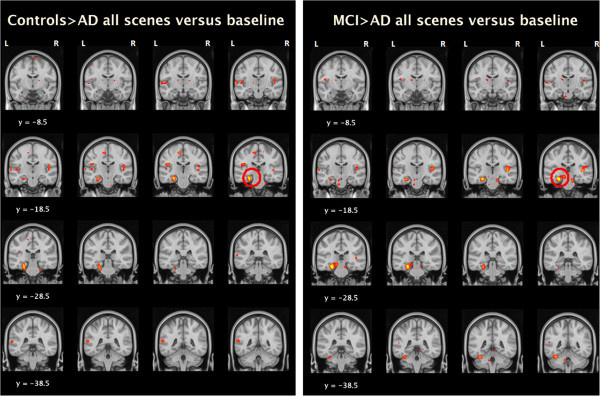
Between group activation differences (Colour scale red-yellow indicates T score, range 2.5-4).